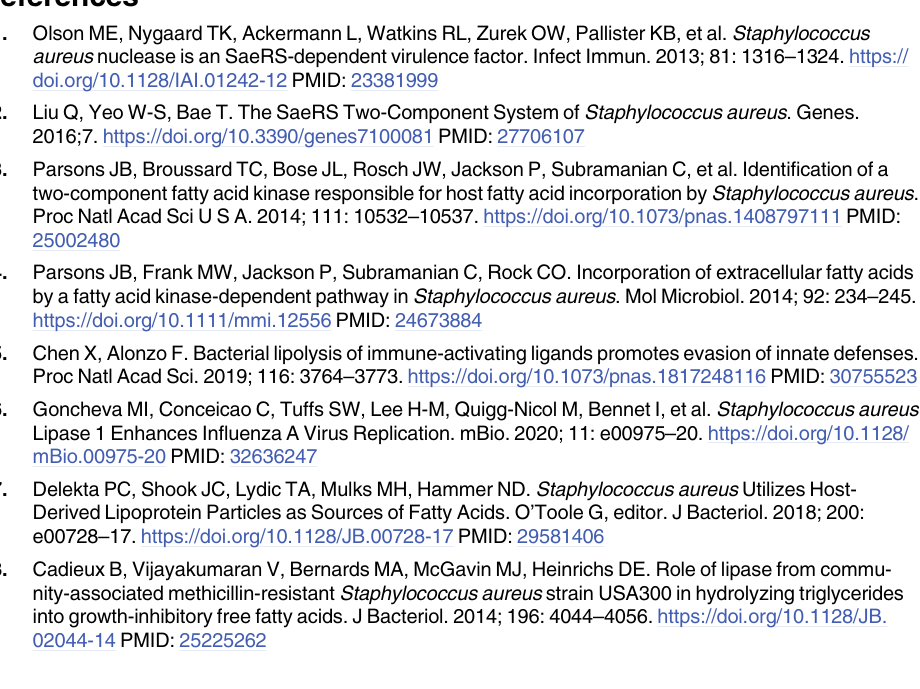
S1 Fig. Uncropped/Unaltered Western blot of SAL3 (from Fig 2). Lane 1: Gold-Bio BLUE- stain molecular weight marker (not visible). Lane 2: Spent medium from culture of protein A- deficient S. aureus strain 6167. Lane 3: 6167 cells. Lane 4: 6167 cells treated with proteinase K (shaved). Lane 5 and 6: Empty wells. Lanes 7 and 8: 6716 Δ gehE ::Tn treated with proteinase K. Lane 9: 6716 Δ gehE ::Tn cells. Lane 10: Spent medium from 6716 Δ g ehE ::Tn culture. Note that in Fig 2 in the manuscript, Lanes 8–10 have been reversed (mirror image) for clarity.